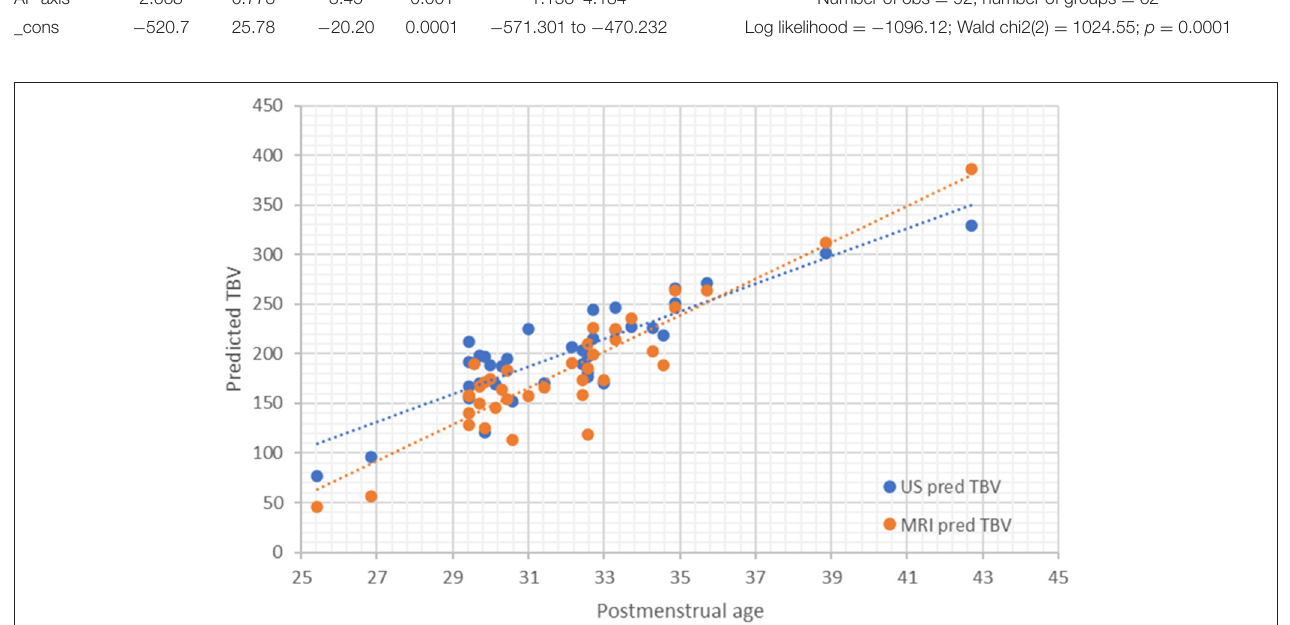
FIGURE 7 | Scatterplot and correlation of predicted-by-axis-TBV by axis in MRI and US.